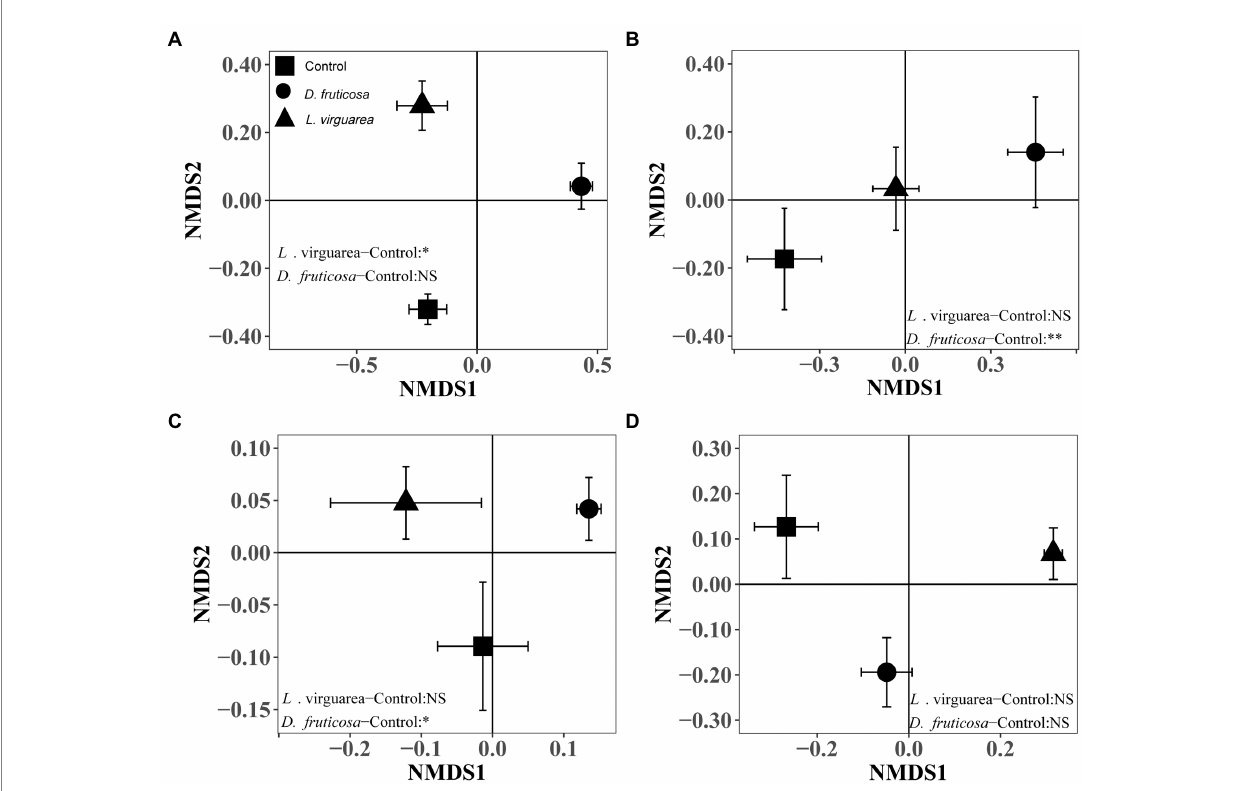
FIGURE 2 Community composition (Mean ± SE) of (A) nematodes, (B) understory plants, (C) bacteria, and (D) fungi associated with each plant treatment (i.e., L. virgaurea and D. fruticosa ) based on non-metric multidimensional scaling (NMDS) using Bray–Curtis similarity index (stress<0.2). Significant results of one-way non-parametric multivariate analysis of variance (NPMANOVA) using Bray–Curtis similarity index are indicated on the right or left bottom part of each graph. **: p < 0.01, *: p < 0.05, (.): p < 0.1, NS: p > 0.05.